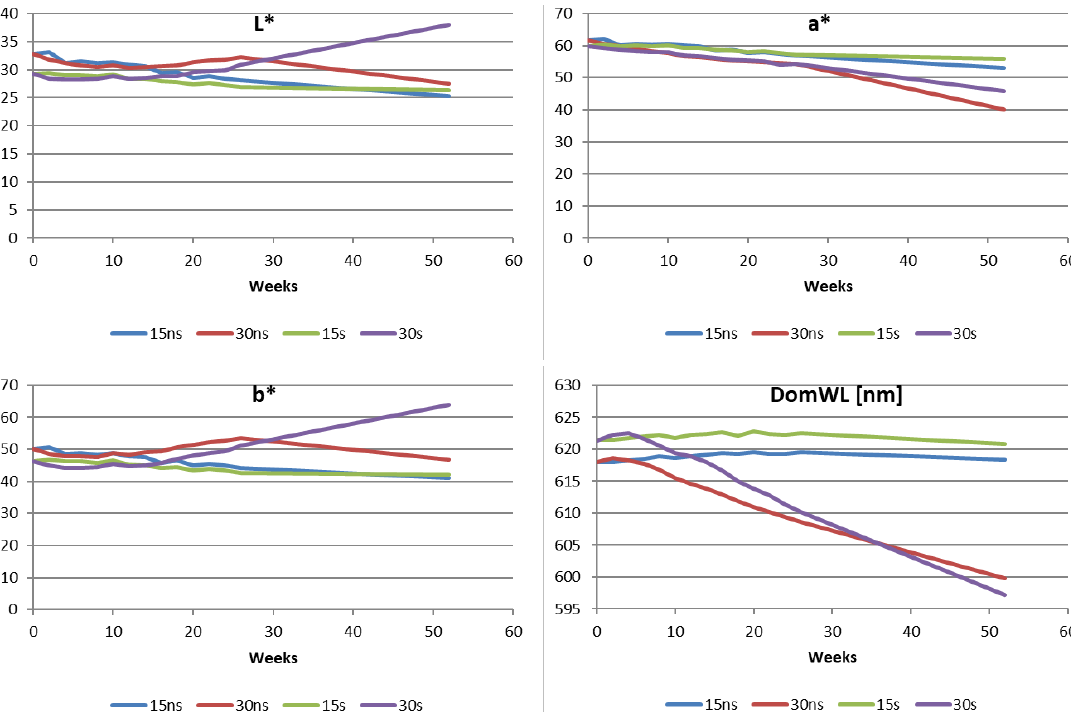
Table 5. Changes of polymeric anthocyanin percentage and the parameters of degradation kinetics of sour cherry liqueurs during storage.